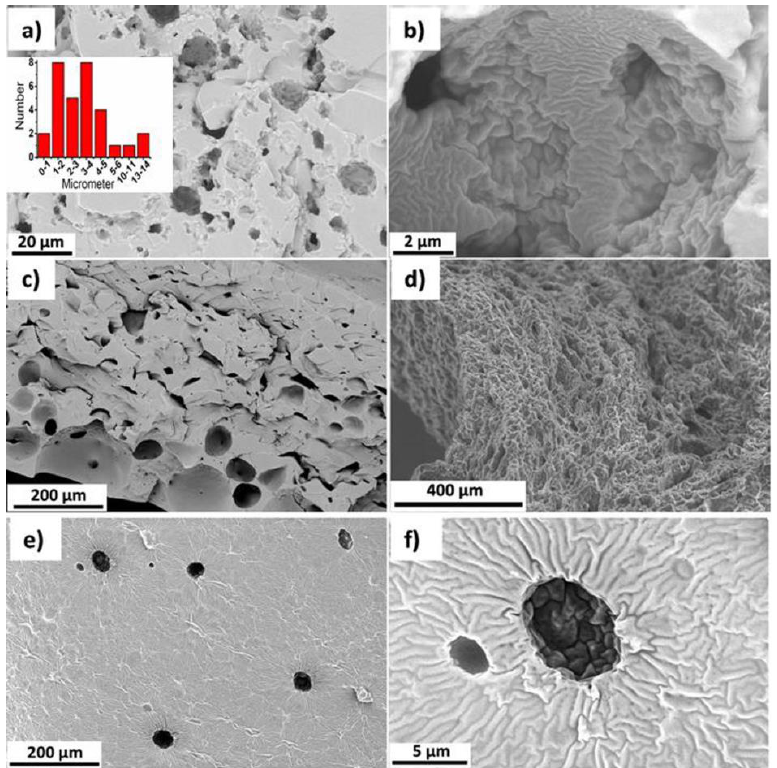
Figure 6. SEM images showing complex morphology of the xerogels in the case of medium internal phase content: multiple emulsion structure and histogram of pores size for f = 0.25 (( a , b ) – sample EG2), gradient emulsion structure for f = 0.33 (( c ) – sample EG5), highly porous monolith for f = 0.5 (( d ) – sample EG10M), and phase separated film from the emulsion with f = 0.8 (( e , f ) – sample EG7). For compositions with f = 0.33 and f = 0.5, gradient emulsion structure [2] was frozen in the xerogels, with smaller pores on the surface and much larger pores on the bottom of